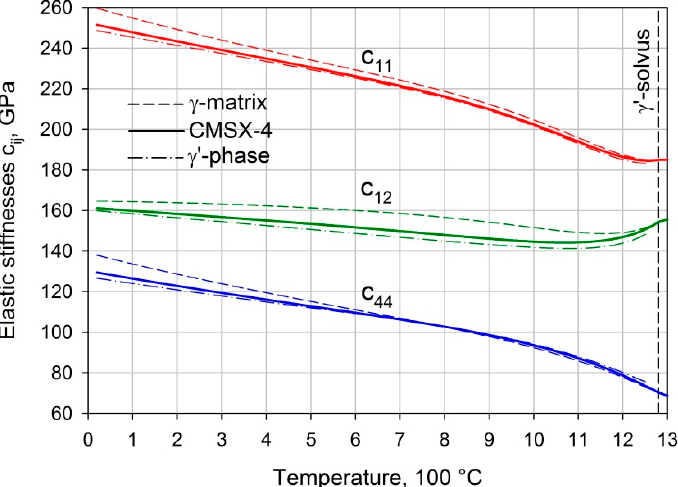
Figure 8. Temperature dependences of the elastic stiffnesses c ij of CMSX-4, its γ -matrix and γ (cid:48) phase.